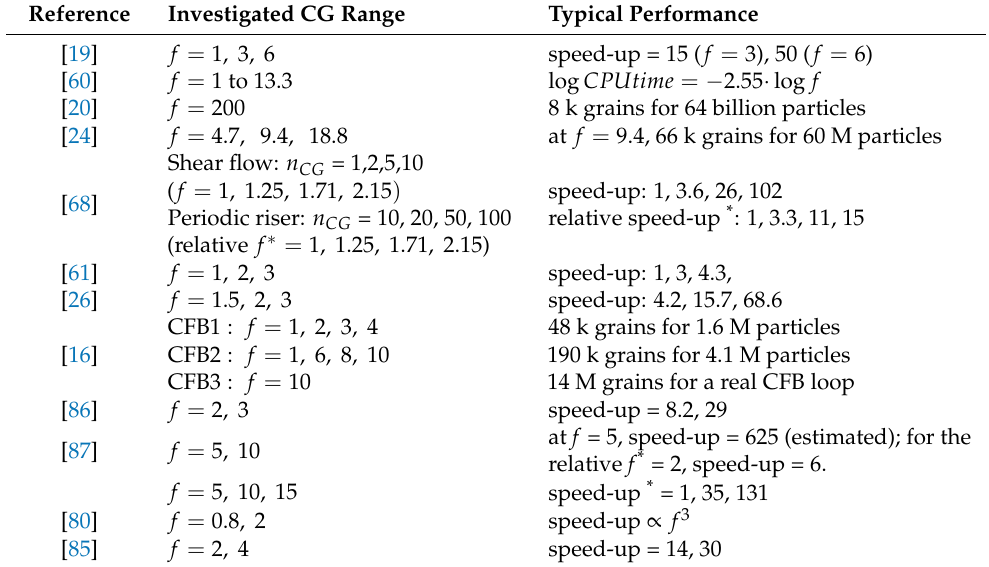
Table 3. List of selected applications of coarse graining approaches and corresponding perfor- mance